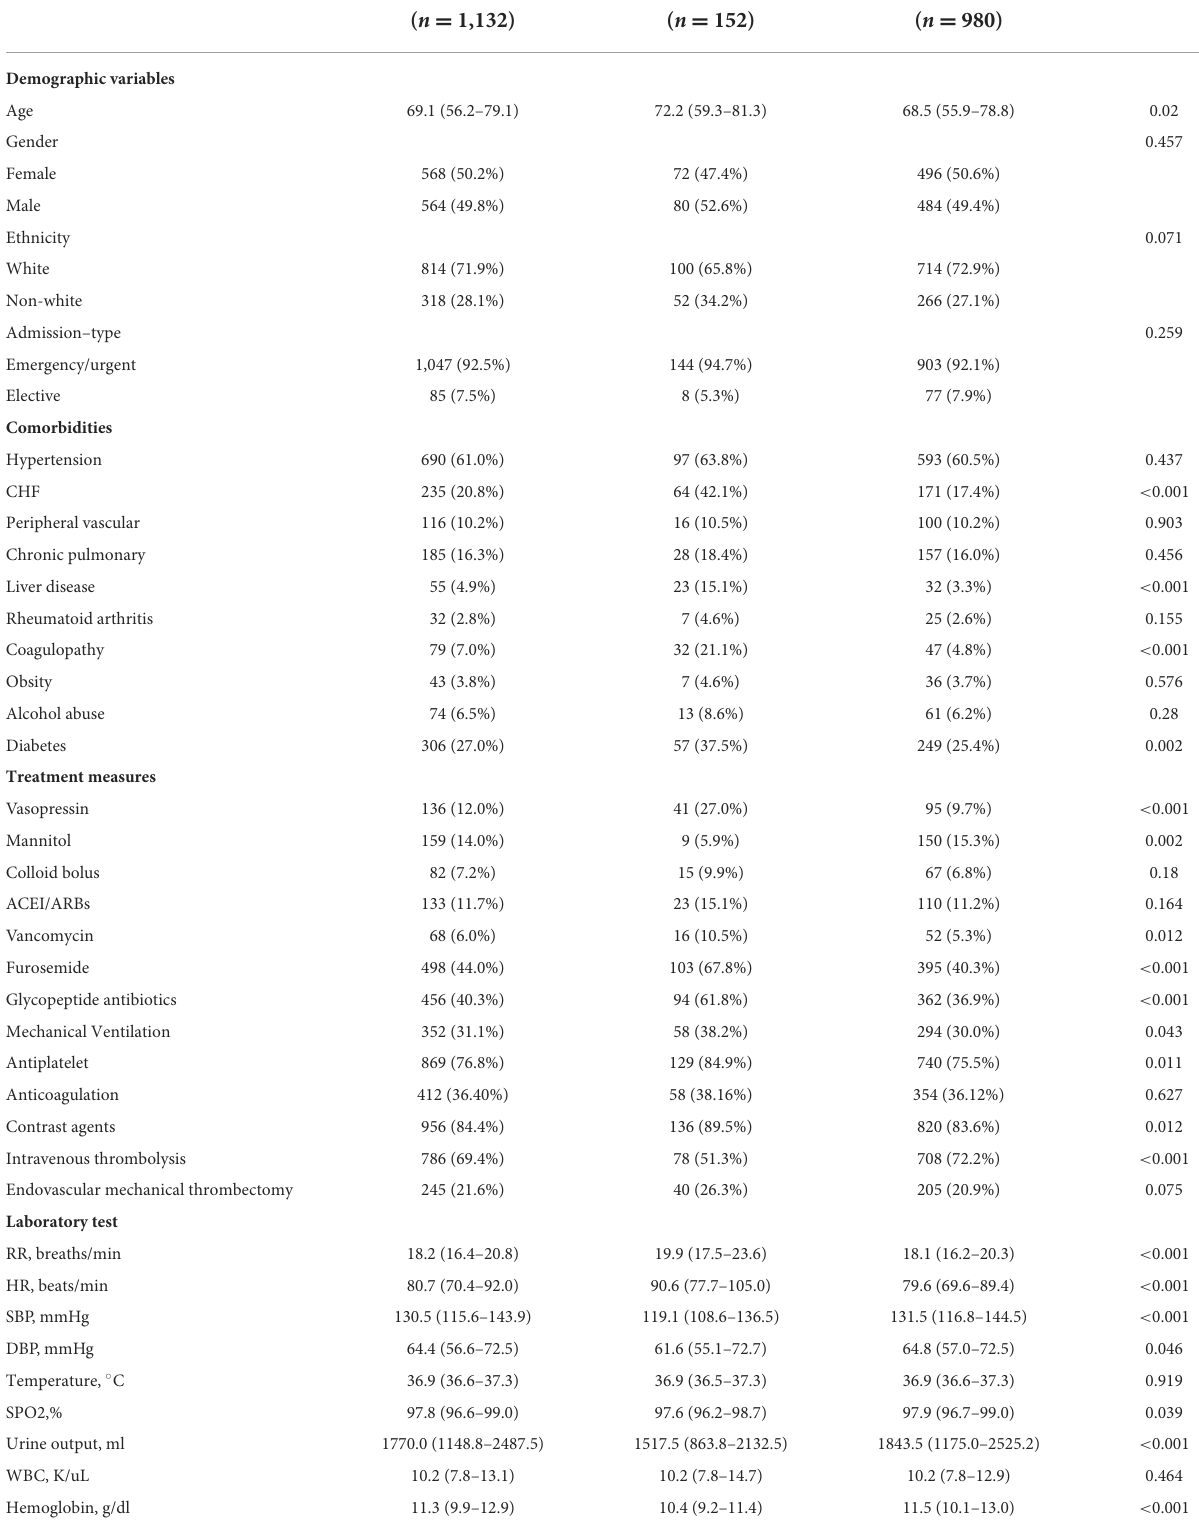
TABLE 1 Characteristics at baseline between acute kidney injury (AKI) and non-AKI